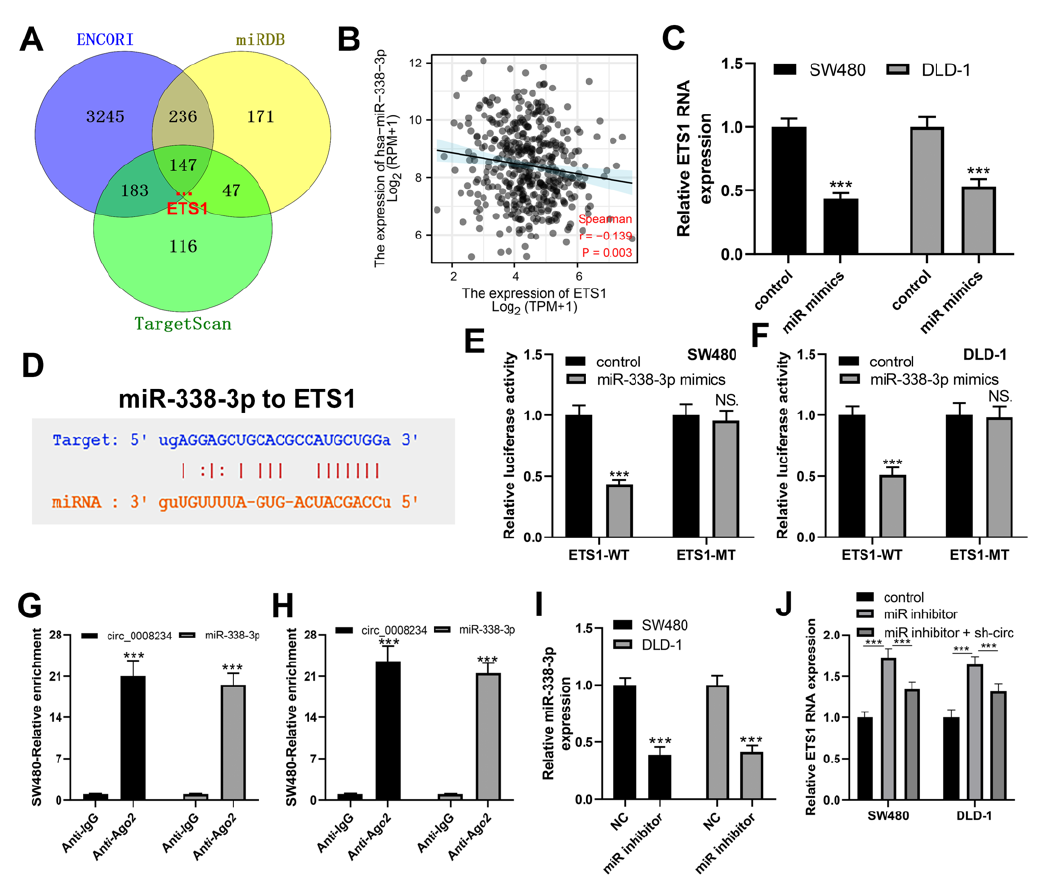
Figure 5. ETS1 is a target gene of miR-338-3p. Notes: ( A ) ENCORI, miRDB, and TargetScan identi fi ed ETS1 as the miR-338-3p targeted gene; ( B ) ETS1 exhibited a positive correlation with miR-338-3p according to the TCGA data; ( C ) The ETS1 mRNA expression in miR-338-3p overexpressed and control cells, *** = p < 0.001; ( D ) The docking site of miR-338-3p and ETS1; ( E , F ) Luciferase